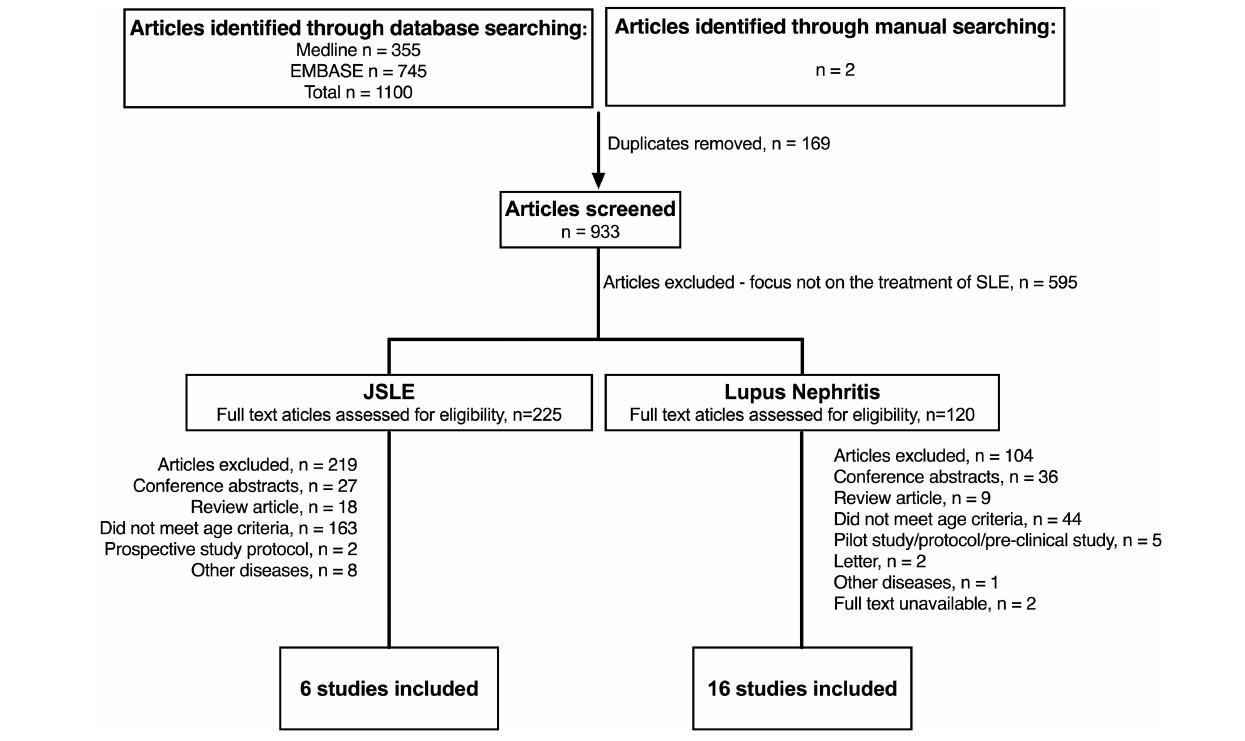
FIGURE 1 | Identification of studies evaluating treatment of JSLE in general and lupus nephritis since 2012. N, number of patients; JSLE, Juvenile Systemic Lupus Erythematosus; SLE, Systemic Lupus